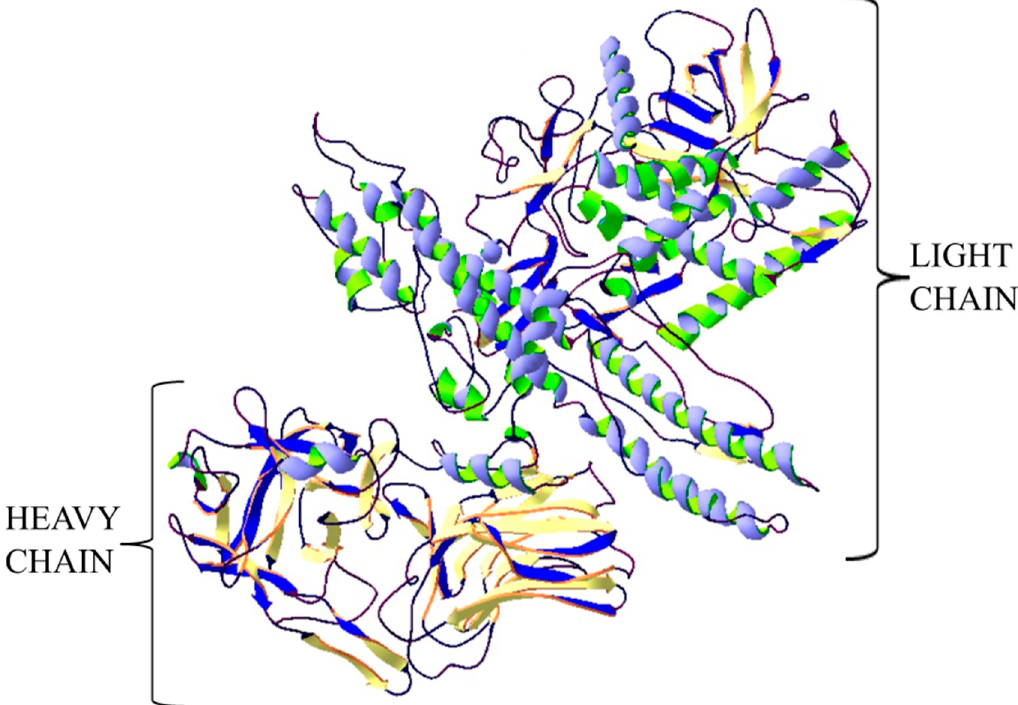
Figure 1. Structure of botulinum neurotoxin type A. The crystal structure of protein (PDB: 3BTA) [28] was taken from the RCSB PDB databank (http://www.rcsb.org/) (access on 05.03.2018). Visualization of the three-dimensional structure of the protein was performed using the Swiss-PdbViewer (http: //spdbv.vital-it.ch/) (access on 05.03.2018.)